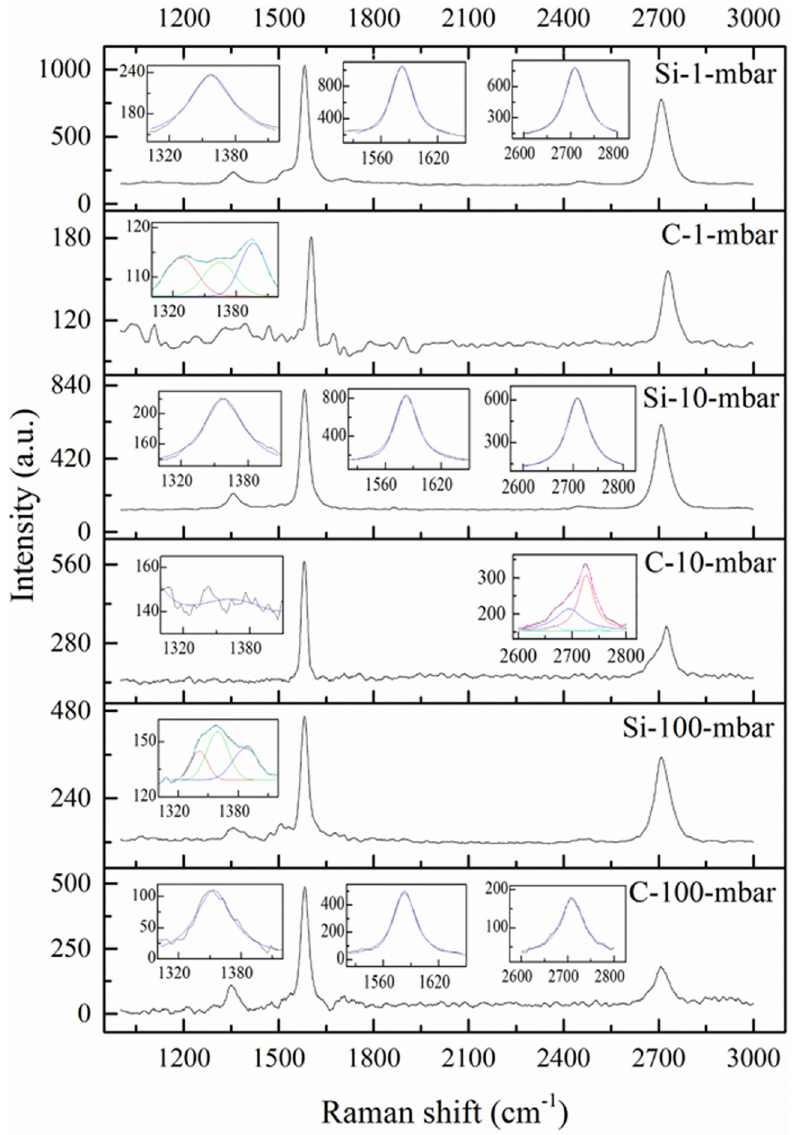
Figure 3. µ -Raman spectra of EG on Si- and C-faced 4H-SiC substrates. The D, G, and 2D band peaks are marked. Insets: Lorentz fits to characterize the width and position of Raman peaks.